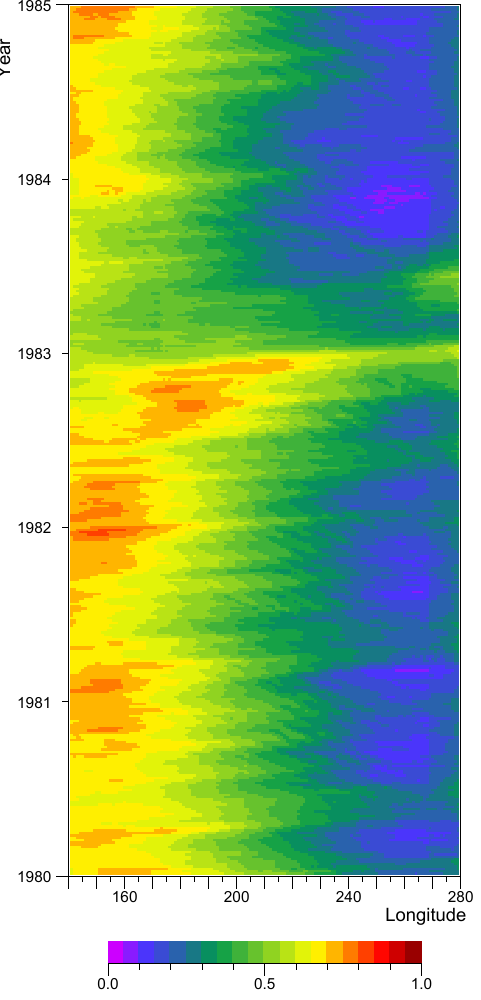
Figure 20. The model SSH (m) at 6 ◦ N as a function of time and